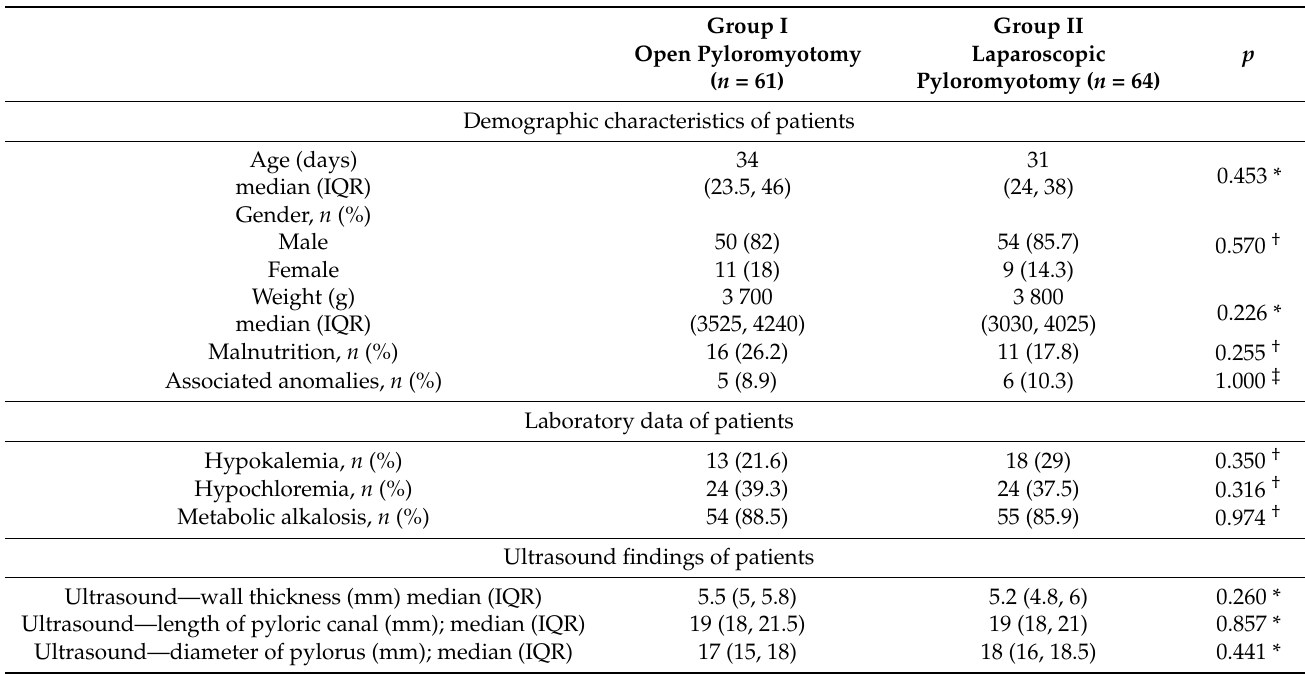
Table 1. Demographic characteristics, laboratory data, and ultrasound findings of patients.